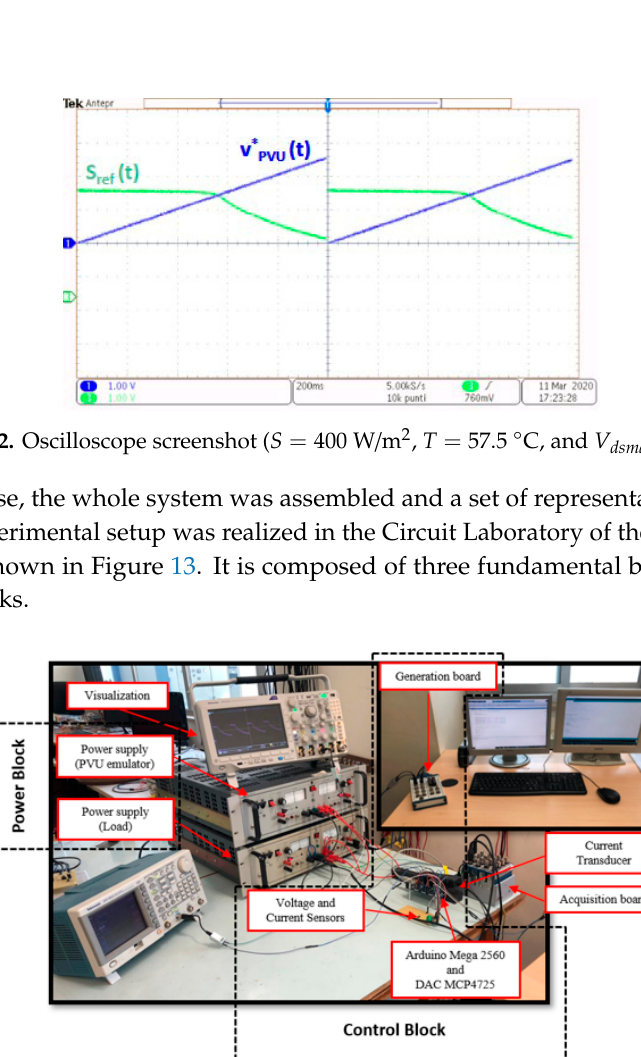
Figure 11. Oscilloscope screenshot ( 𝑆 = 200 W/m 2 , 𝑇 = 57.5 °C , and 𝑉 (cid:3031)(cid:3046)(cid:3040)(cid:3028)(cid:3051) = 100 V).